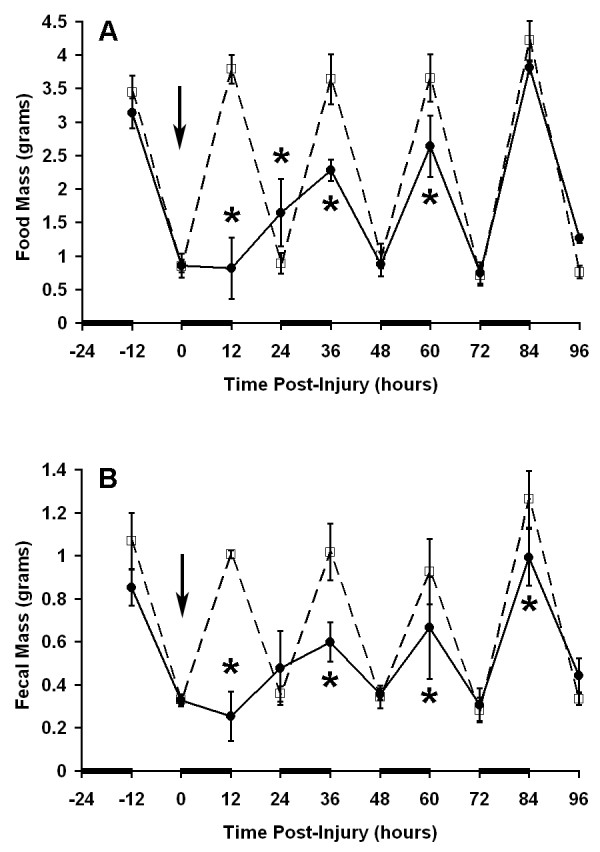
Induction of ileus after thermal injury. Twelve hour measurements were are plotted as described in legend for Figure 2. A 20% total body surface area scald burn was induced at time 0 (solid line). Control mice received anesthesia only (dashed line). N = 3 mice per group. * P = 0.05 vs. control at corresponding time point.